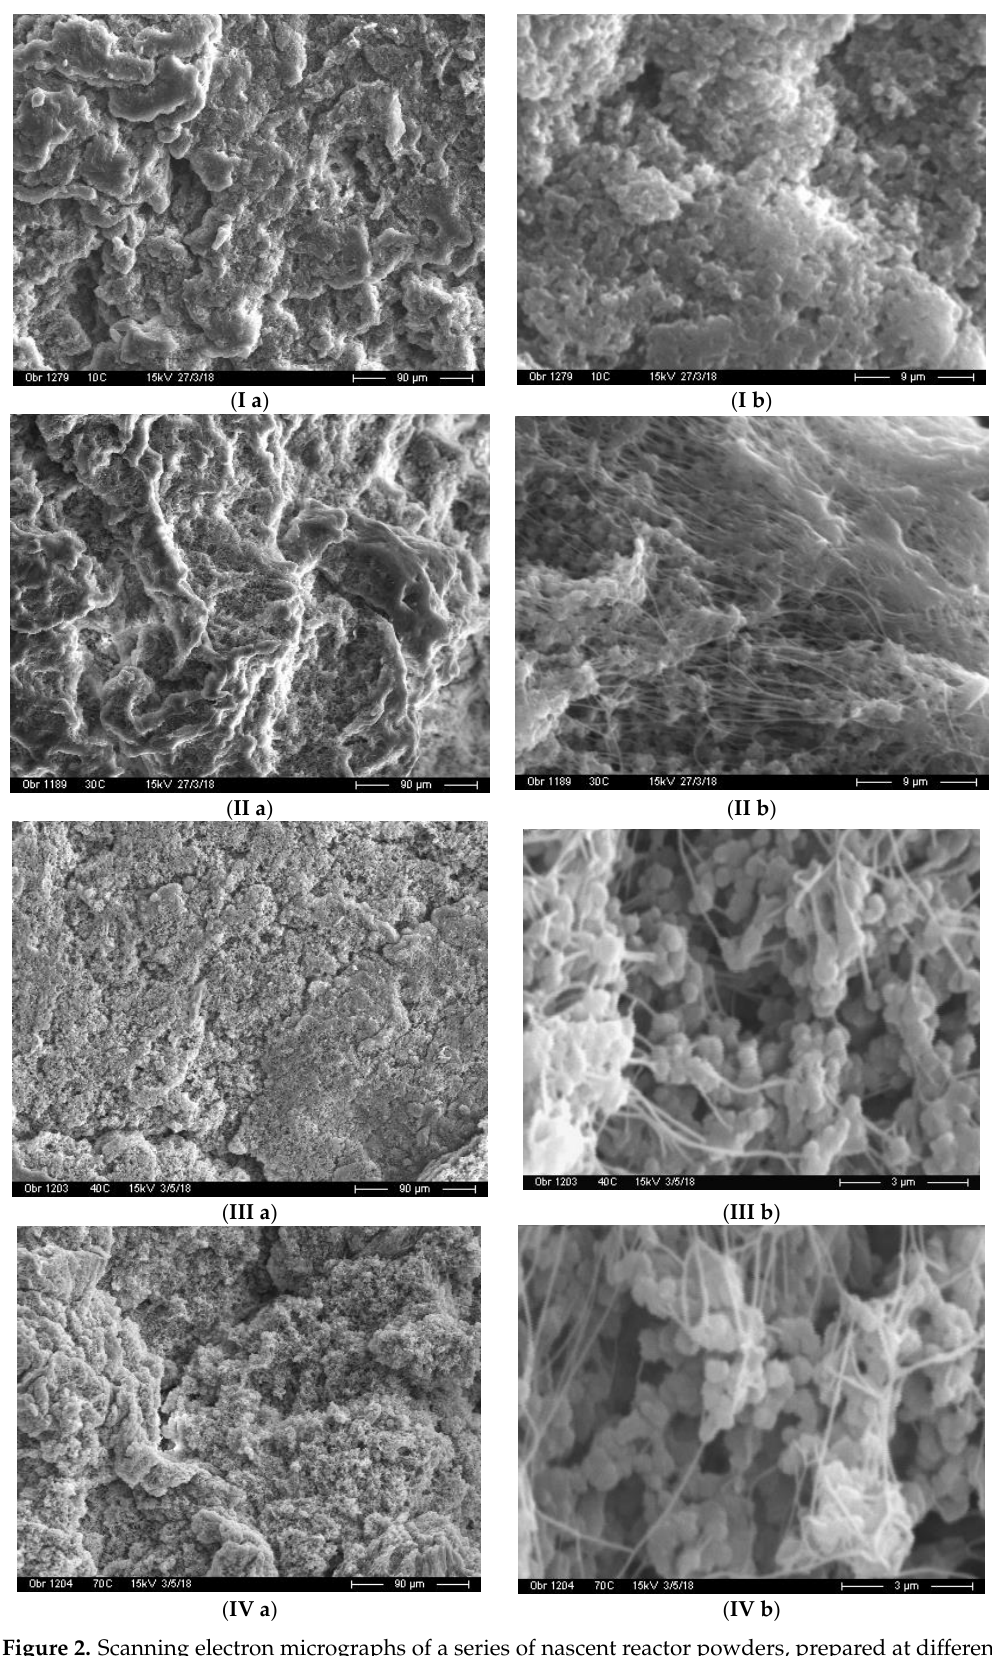
Figure 2. Scanning electron micrographs of a series of nascent reactor powders, prepared at different T poly : 10 °C ( I a,b ); 30 °C ( II a,b ); 40 °C ( III a,b ); and 70 °C ( IV a,b ).